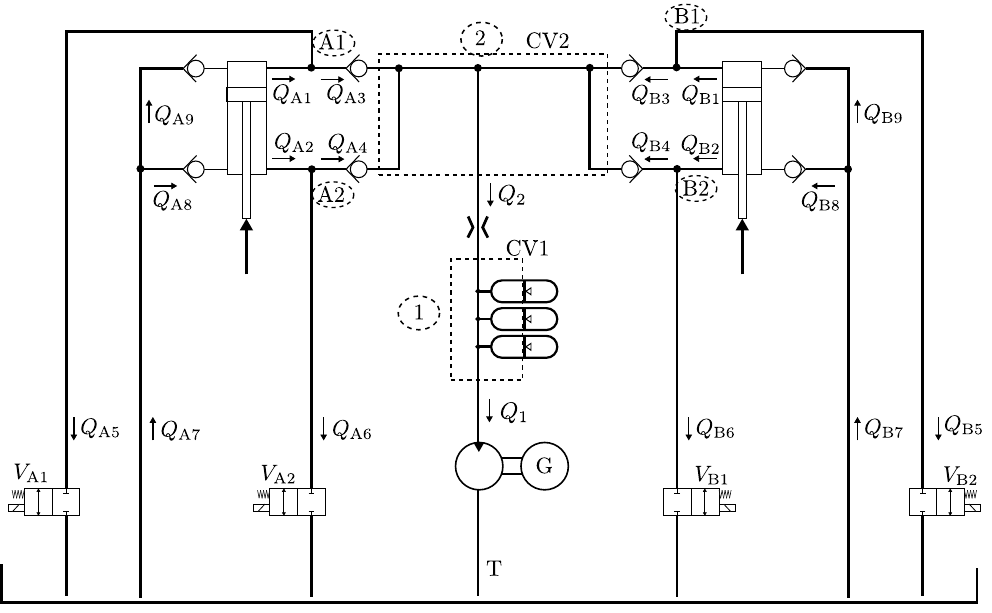
Figure 4. The hydraulic diagram of the PTO